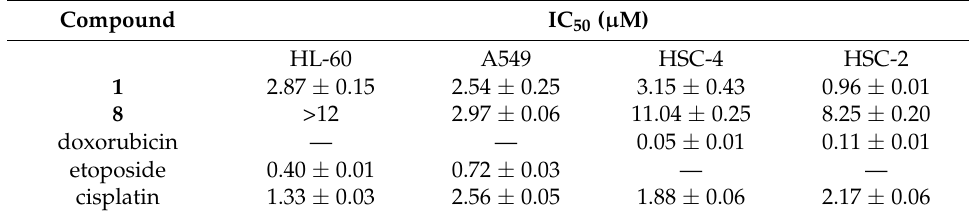
Table 3. Cytotoxic activity of 1 – 15 against HL-60, A549, HSC-4, and HSC-2 cells a,b